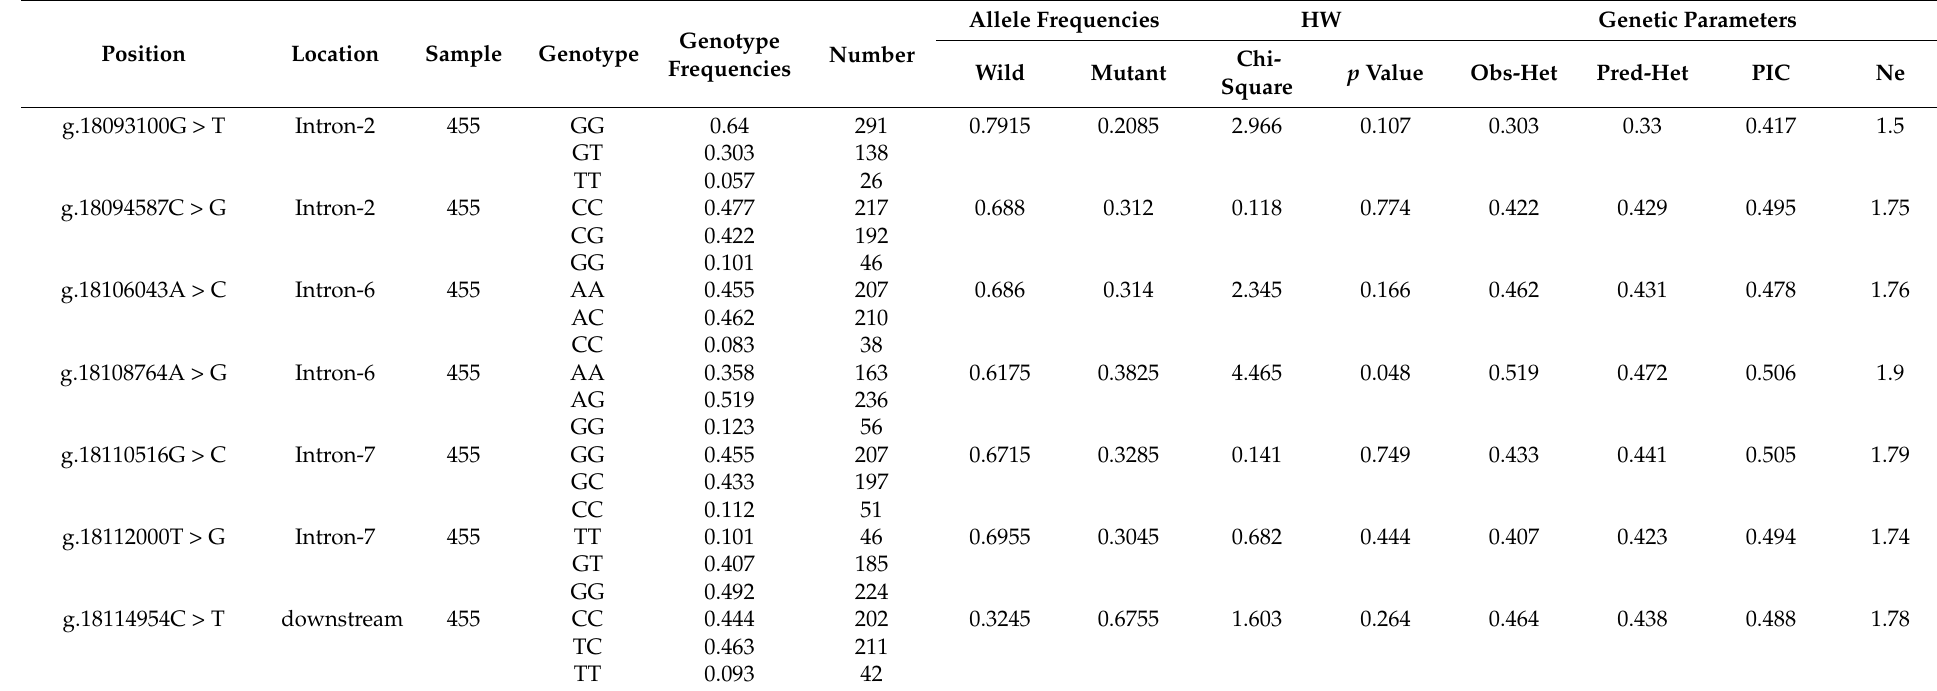
Table 3. Genotype, allele frequency and genetic parameters of seven SNVs in the NR6A1 gene in Dezhou donkeys.